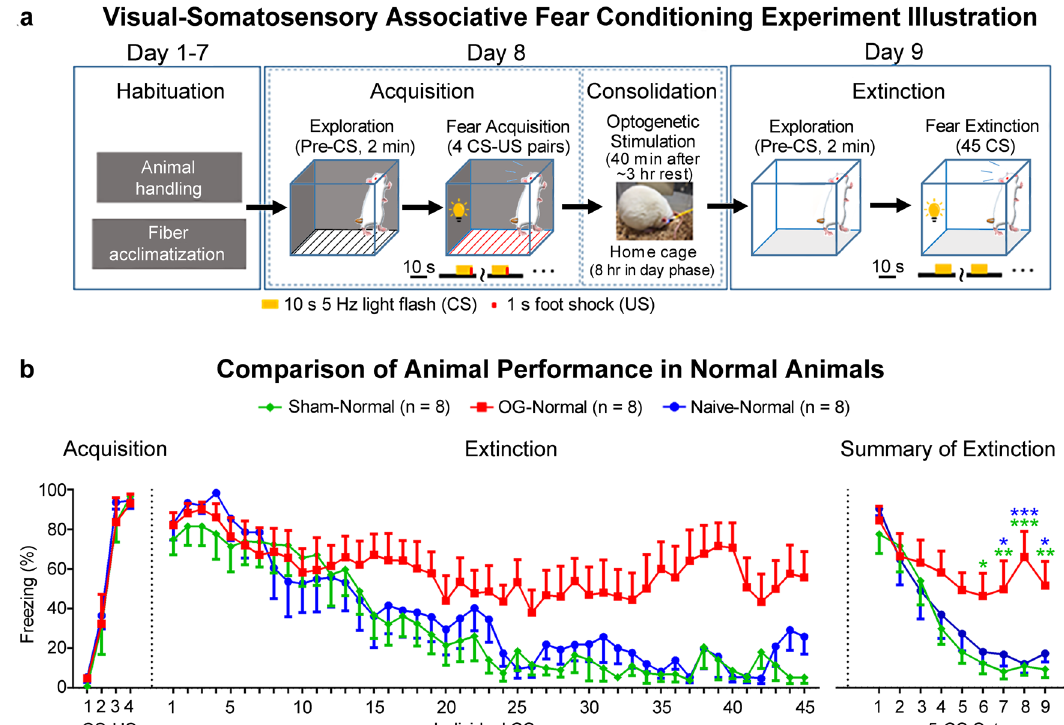
Fig. 5 | Optogenetically-initiated brain-wide spindle-like activities at VPM enhance visual-somatosensory associative memory consolidation. a Fear con- ditioning experimental design and timeline (CS, conditioned stimulus, 10s 5Hz light fl ash; US, unconditioned stimulus, foot shock). All experiments were per- formed in day phase. Optogenetics (OG) and Sham animals received 40min 8Hz 24-pulse stimulations during memory consolidation. b Comparisons of freezing